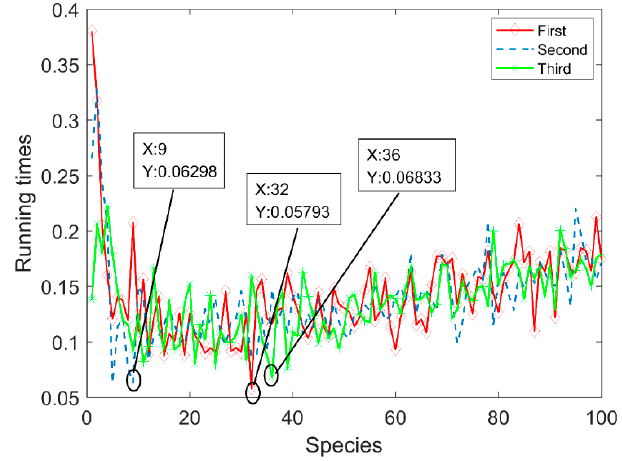
Figure 3. Different species running times. Figure 3. Di ff erent species running